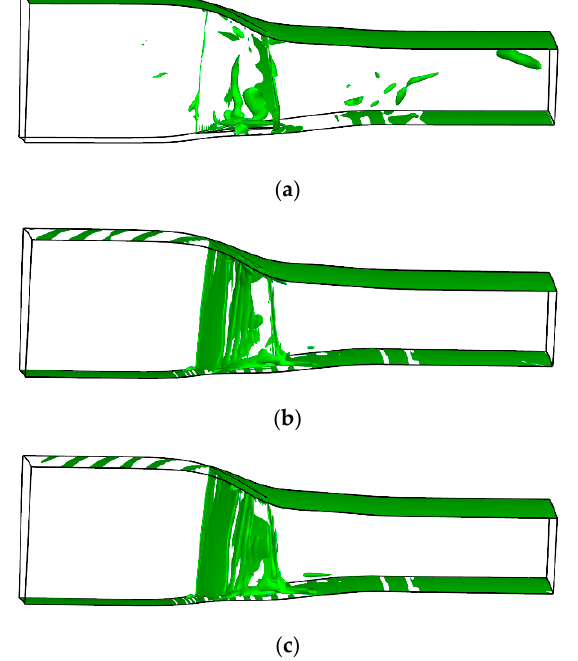
Figure 8. Iso − surface of Q value 8 1 10 Q = × in the NASA rotor 37 at ( a ) NS condition, ( b ) design con- Figure 8. Iso–surface of Q value Q = 1 × 10 8 in the NASA rotor 37 at ( a ) NS condition, ( b ) design dition, ( c ) NC condition. condition, ( c ) NC